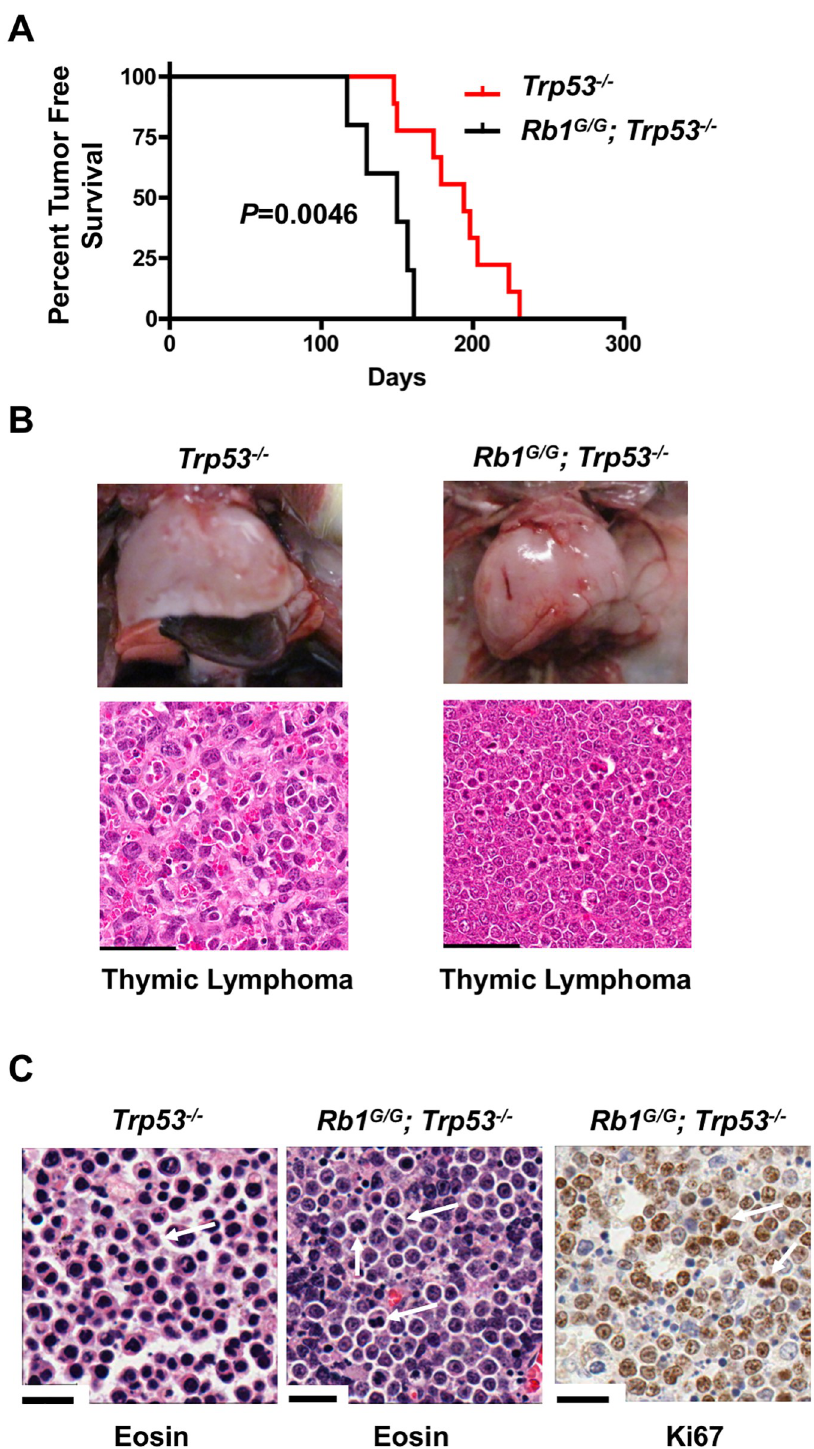
Fig 2. The Rb1 G mutation enhances cancer susceptibility of Trp53 -/- mice. (A) Kaplan-Meier analysis of tumor-free survival of the indicated genotypes. Mice were monitored until their natural endpoint and those having tumors are shown. Rb1 G/G ; Trp53 -/- (150 days, n = 5), Trp53 -/- (194 days, n = 9) are statistically significant from one another using the log-rank test (p = 0.0046). (B) Whole mount and H&E analysis of thymic lymphomas found in both Rb1 G/G ; Trp53 -/- and Trp53 -/- mice. Scale bars are equal to 50 μ m. (C) Histology of select tumors from Rb1 G/G ; Trp53 -/- and